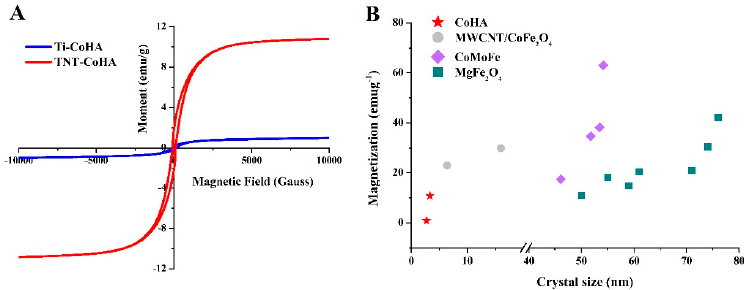
Figure 5. ( A ) Mass magnetization of CoHA and TNT ‐ CoHA by a superconducting quantum interference device (SQUID). ( B ) Magnetic nanoparticle crystal size effects on magnetic behavior by XRD. Other magnetic nanoparticles data taken from MWCNT/CoFe 2 O [12], CoMoFe [34], and MgFe 2 O 4 [35].